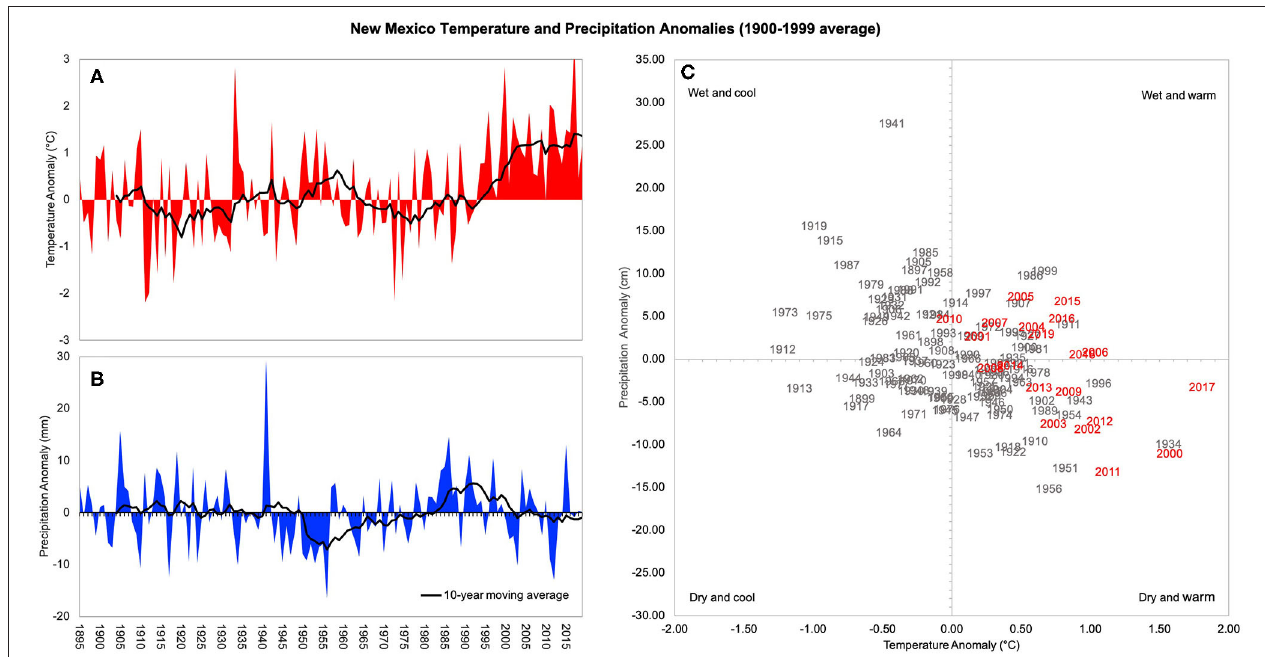
FIGURE 6 | Annual precipitation and temperature anomalies (1900–1999 average) for New Mexico from 1900 to 2019. (A) shows a timeseries of New Mexico’s annual temperature anomalies and (B) precipitation anomalies. (C) Compares annual anomalies based on the Water Year (October-September). All 20th century years are gray and 21st century years are